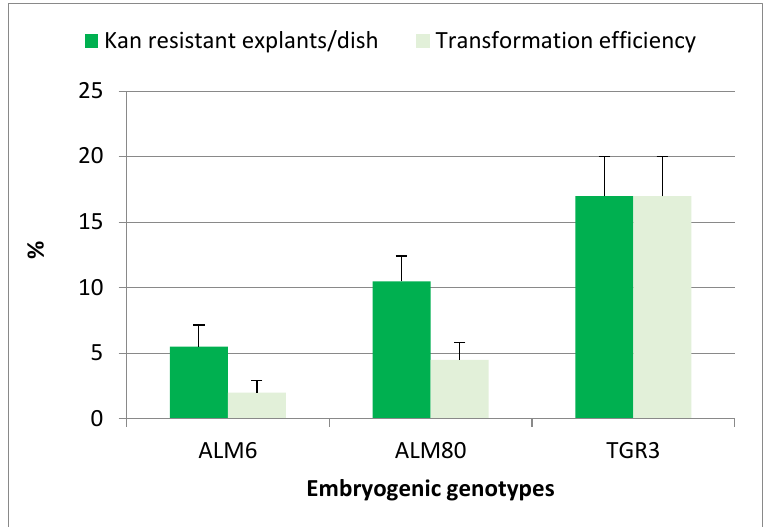
Figure 2. Effect of genotype on the percentage of kanamycin-resistant explants and transformation efficiency of cork oak somatic embryos transformed with strain EHA105pK7TAU. Ten Petri dishes were used for each genotype and each Petri dish contained 10 groups of somatic embryos. Vertical lines indicate the standard errors of mean values.